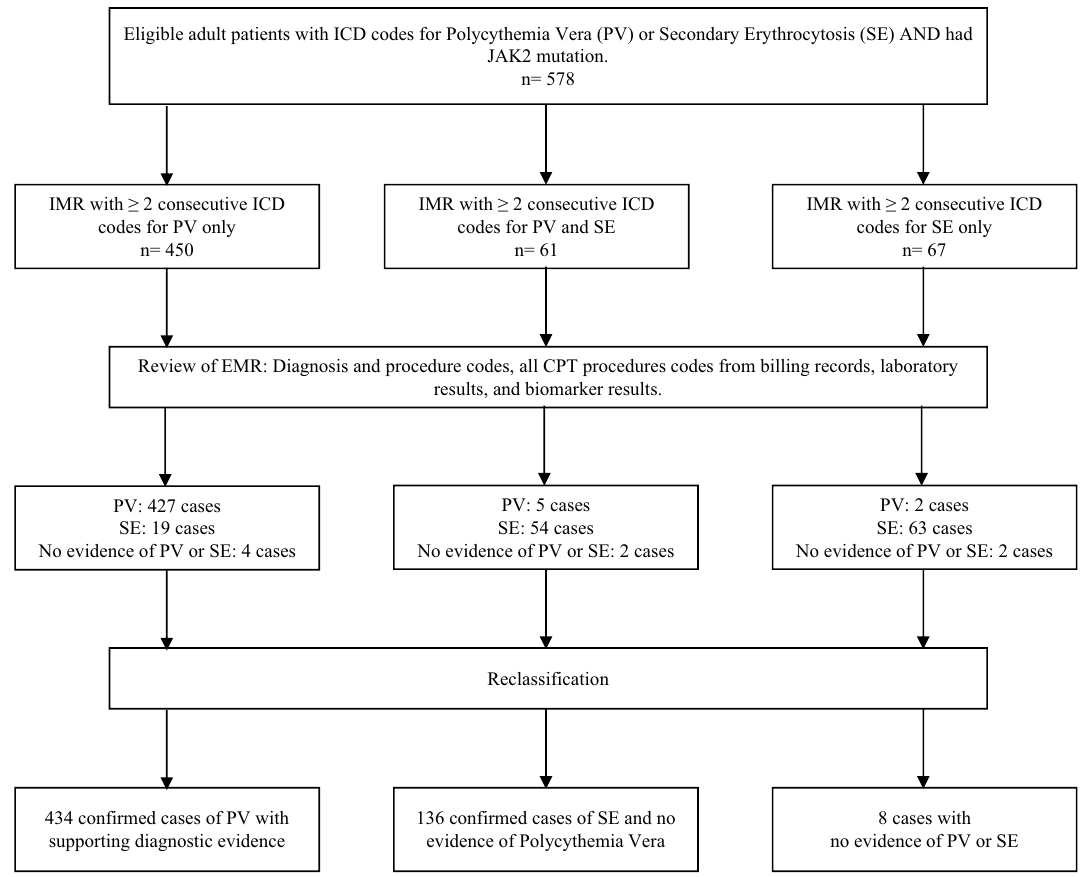
Figure 1. Retrospective review of electronic medical selection and analysis